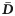
The TTT diagram for polycrystalline Al with various D¯.